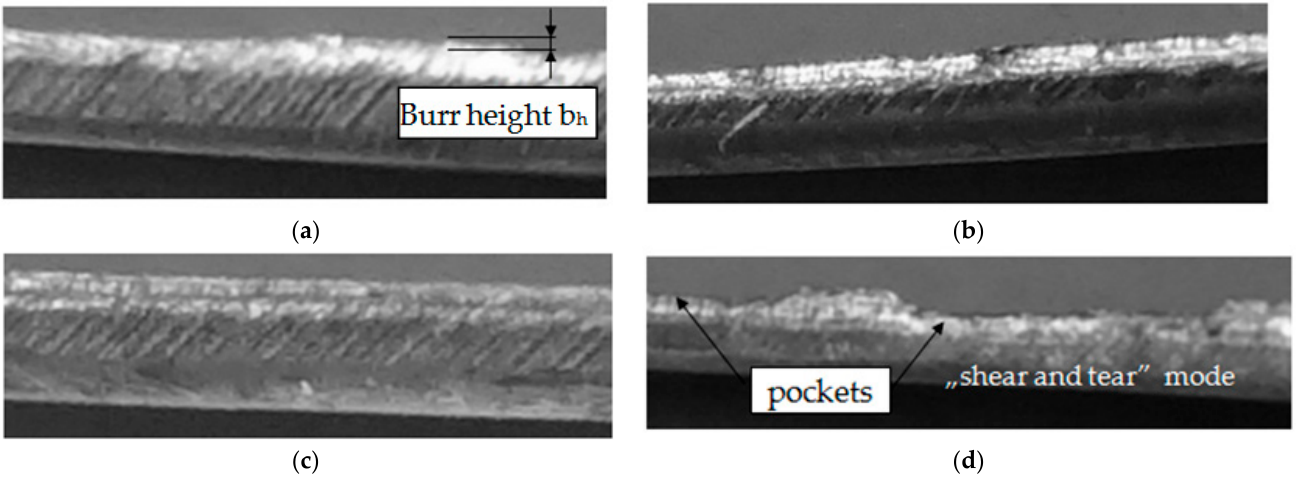
Figure 11. View of the sheared edges under study: ( a ) v 2 = 3 m/min, c h = 0.04 mm, α = 30°; ( b ) v 2 = 13 m/min, c h = 0.04 mm, α = 30°; ( c ) v 2 = 18 m/min , c h = 0.04 mm, α = 30 ° ; ( d ) v 2 = 3 m/min, c h = 0.08 mm, α = 30°.